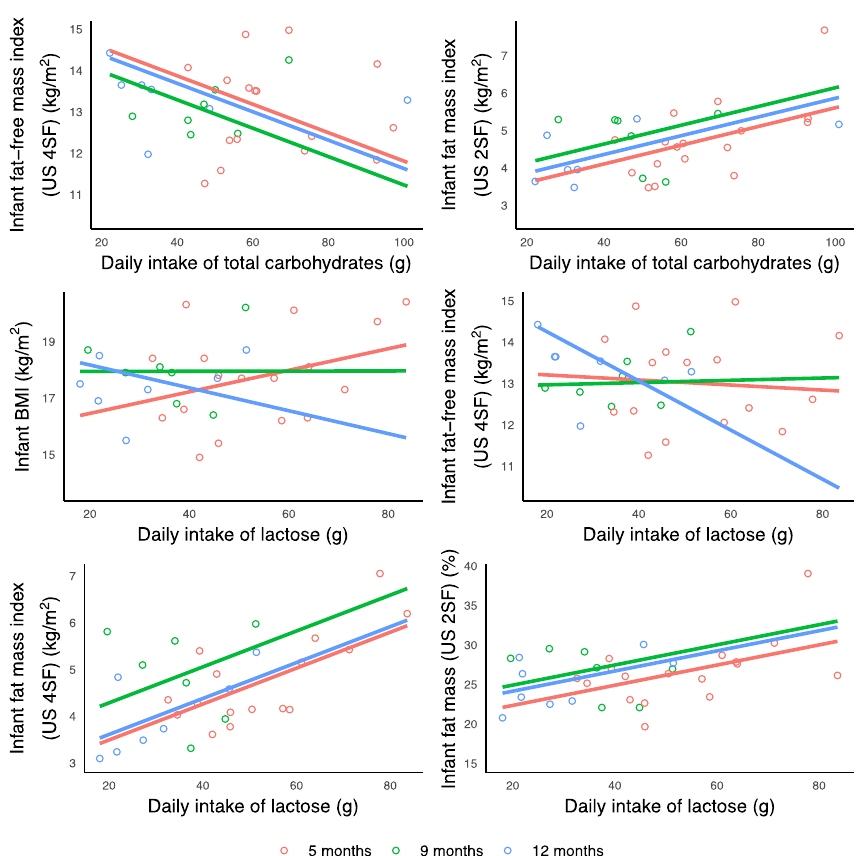
Figure 3. Significant associations between calculated daily intakes of carbohydrates and infant body composition measurements. Lines represent linear regression and grouped by the month of lactation.